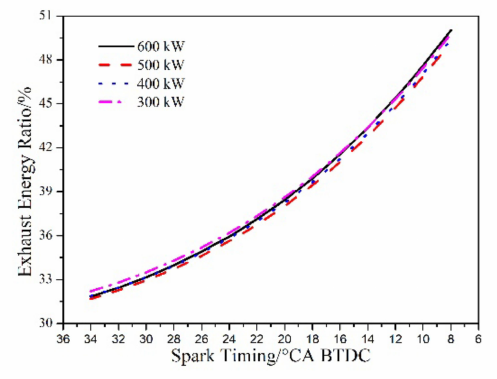
Figure 10. Exhaust gas